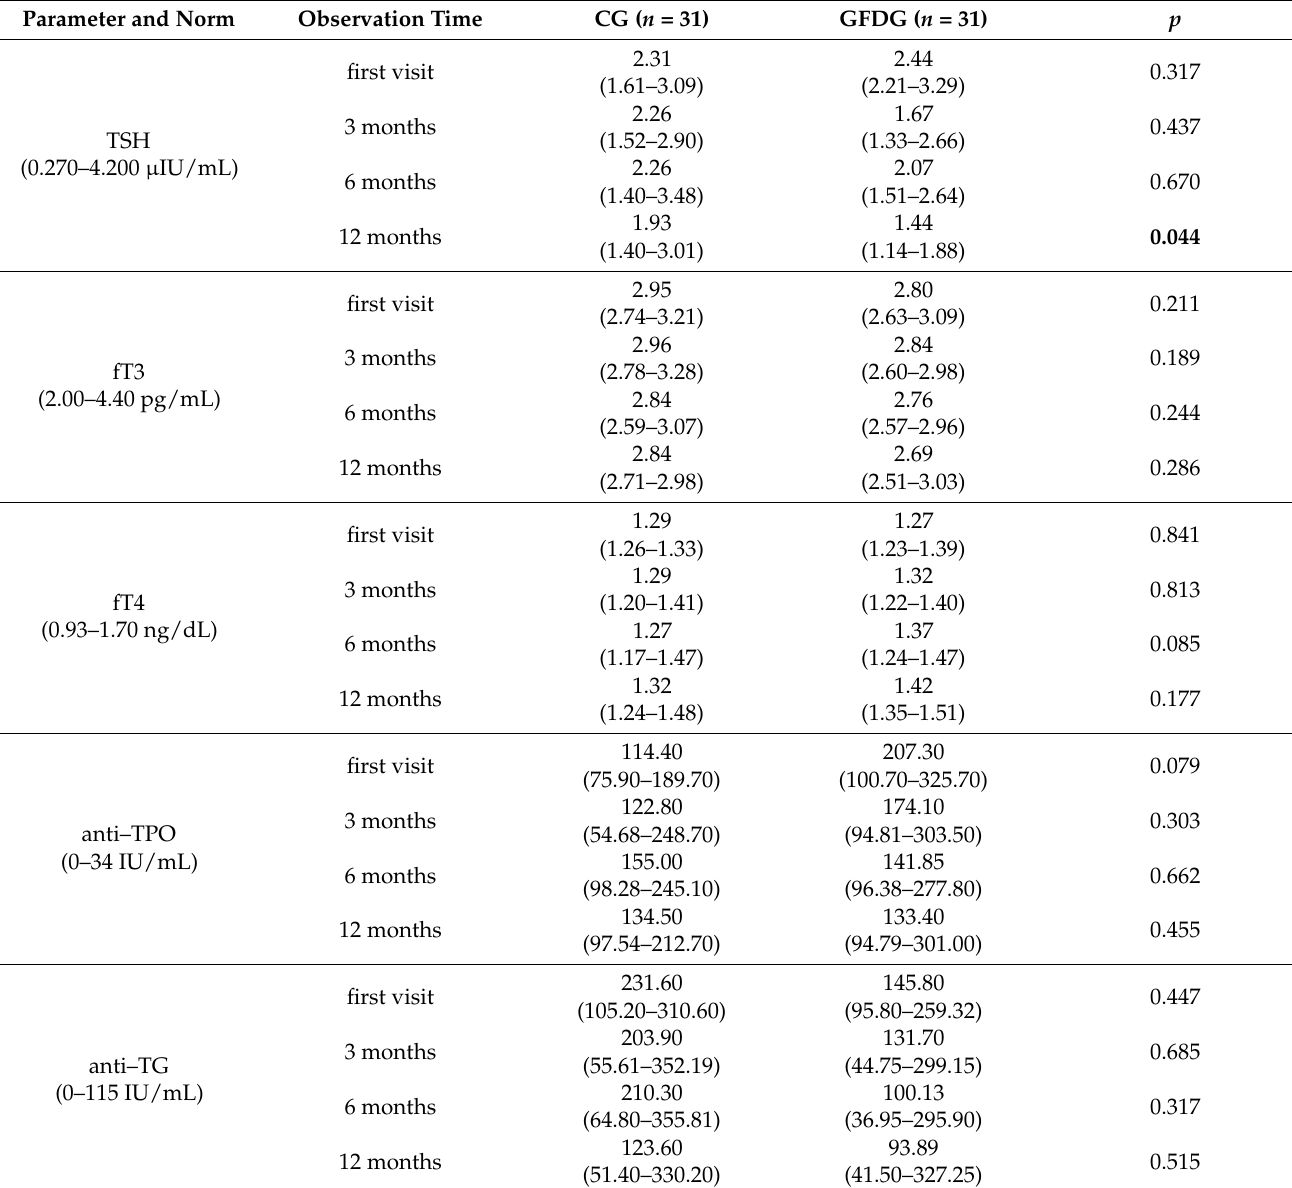
Table 2. Median concentrations of analyzed biochemical parameters throughout the observation period ( n =